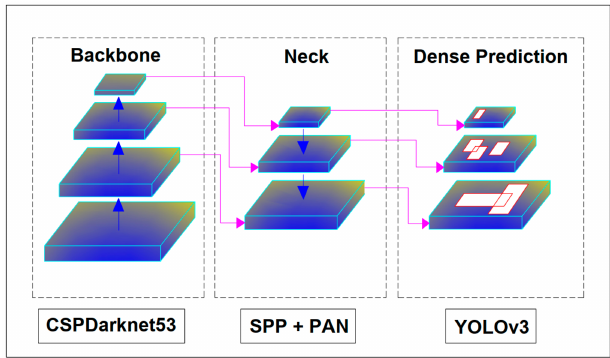
Figure 1. Network architecture of